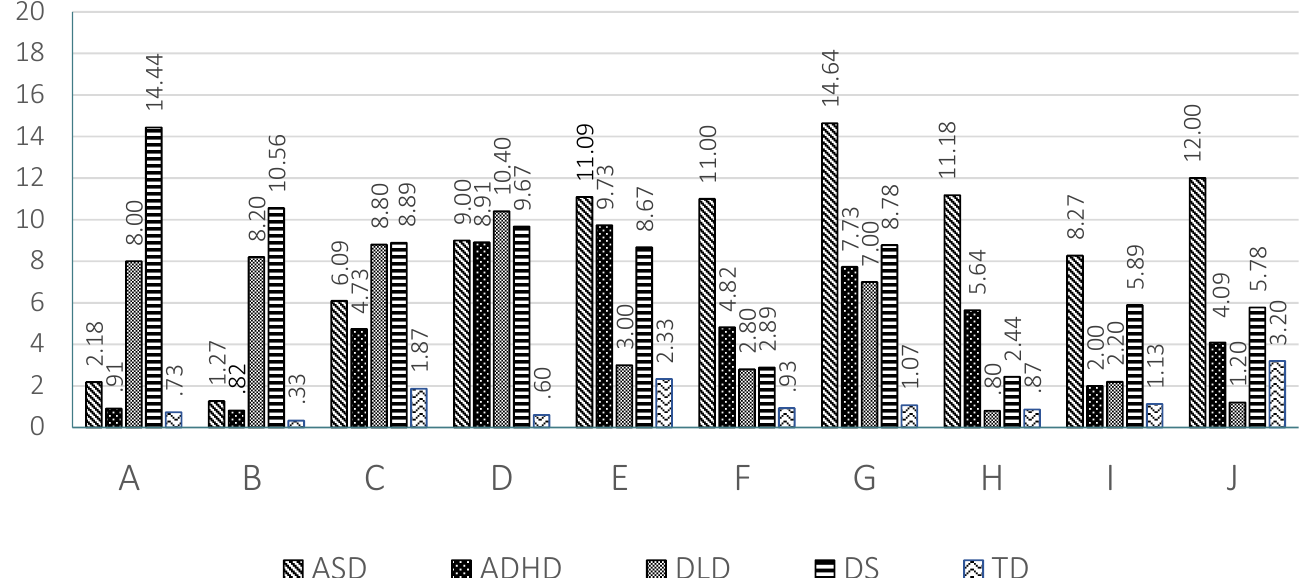
Figure 2. Means obtained by the 5 groups at school age in the 10 scales of the Galician CCC-2.